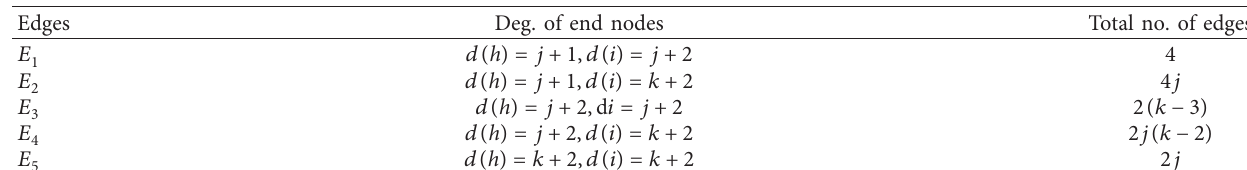
Table 2: Points of edge partitioning of P